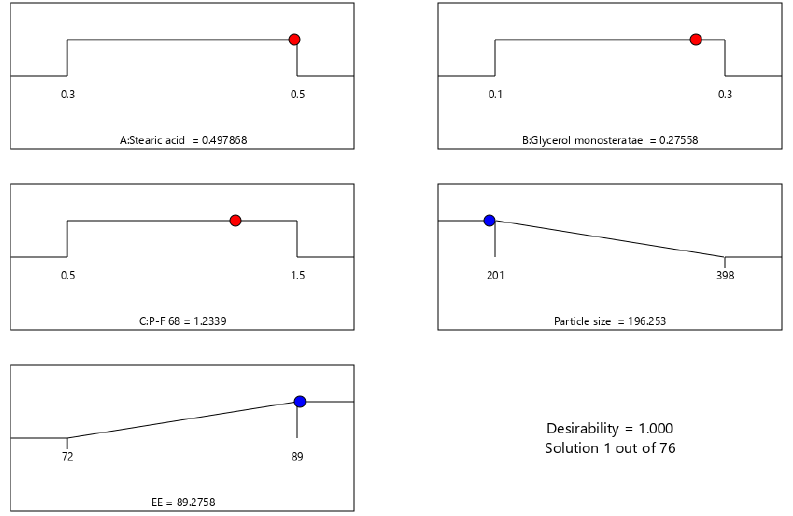
Figure 4. Desirability bar graph for the optimized result.